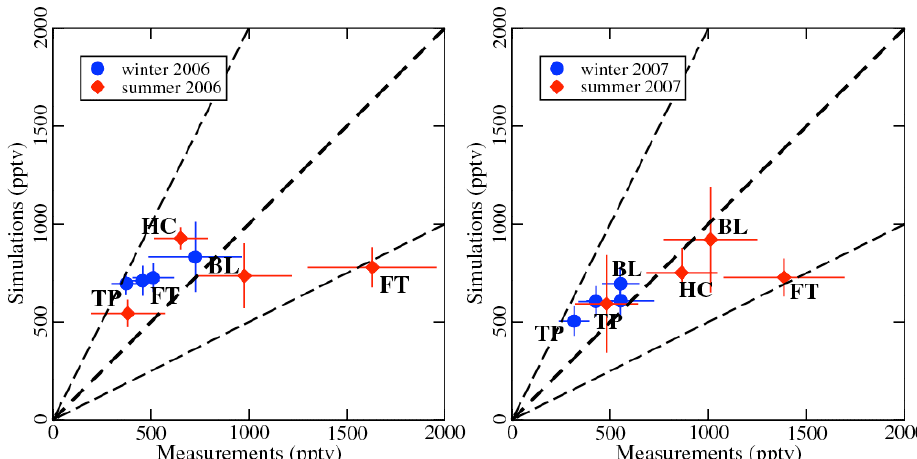
Figure 3. Relation between simulated and measured acetone vmr (pptv) for flights of 2006 and 2007 to Manila. Annual averages are derived from co-located simulations and airborne acquisition, making distinction according to the air mass fingerprint defined by Köppe et al. [2009], as FT for Free Troposphere, BL for Boundary Layer, HC for High Clouds and TP for tropopause. In winter 2007, dots not identified correspond to FT air mass. Vertical and horizontal bars depict the standard deviation of acetone simulated and measured, respectively. Superimposed are three lines showing agreement (x=y), and a factor 2 difference between simulation and measurement (y=2x and y=x/2).